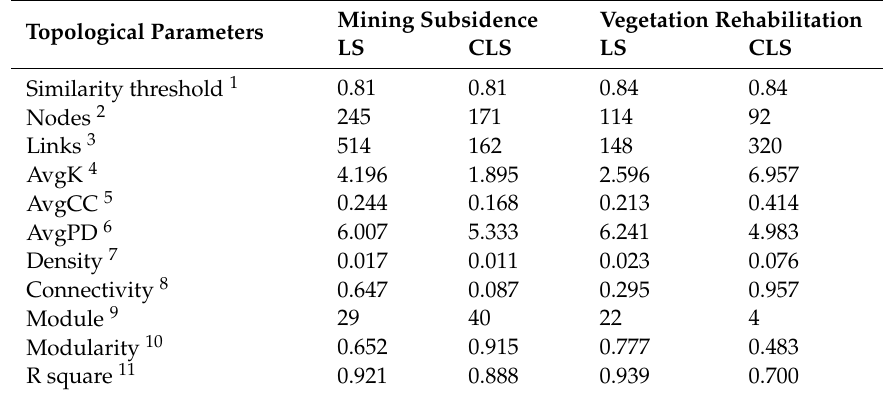
Table 2. Topological properties of soil bacterial molecular ecological networks in mining subsidence and vegetation